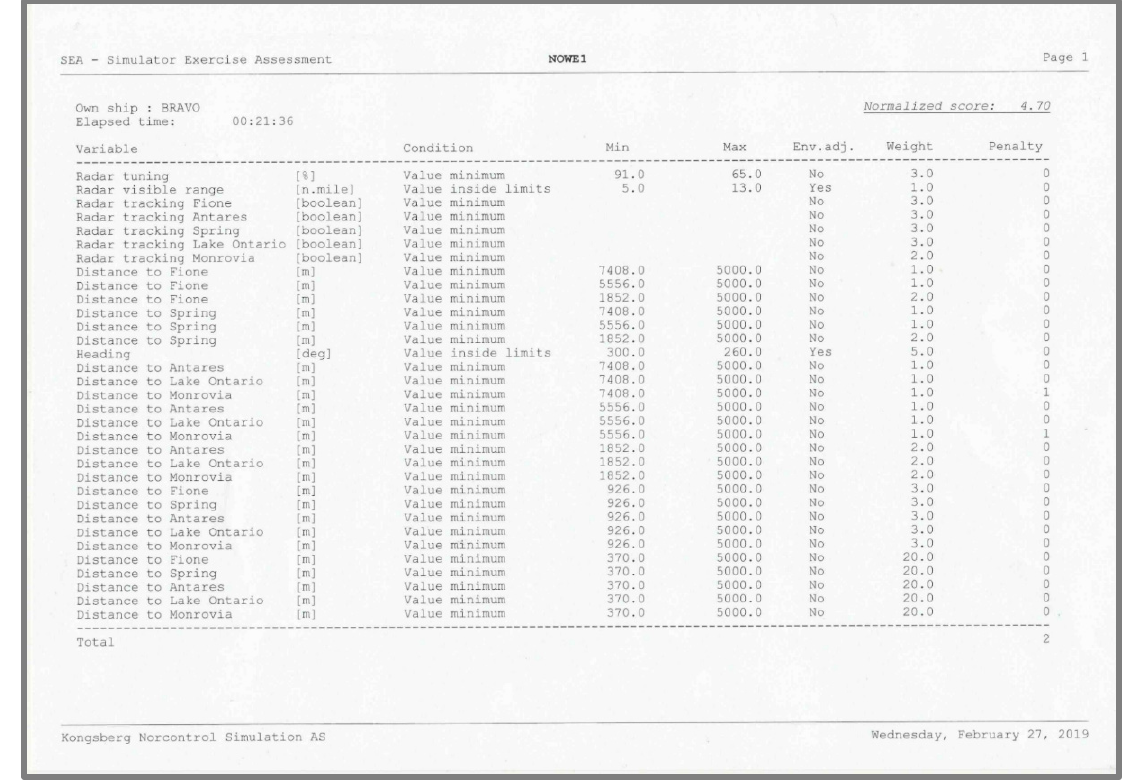
Figure 8. Example of the final report and assessment for the ship BRAVO.